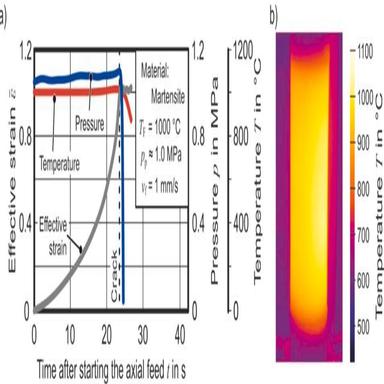
a) Effective strain ε, pressure p and temperature T as function of time t after starting the axial load and b) temperature distribution T(z,r) during the pressurized-tube-tensile test.